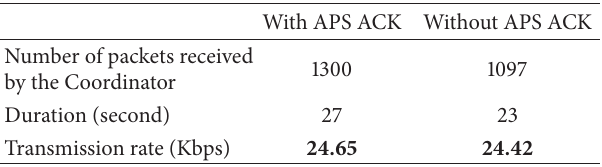
Table 1: Empirical results of transmission throughput. With APS ACK Without APS